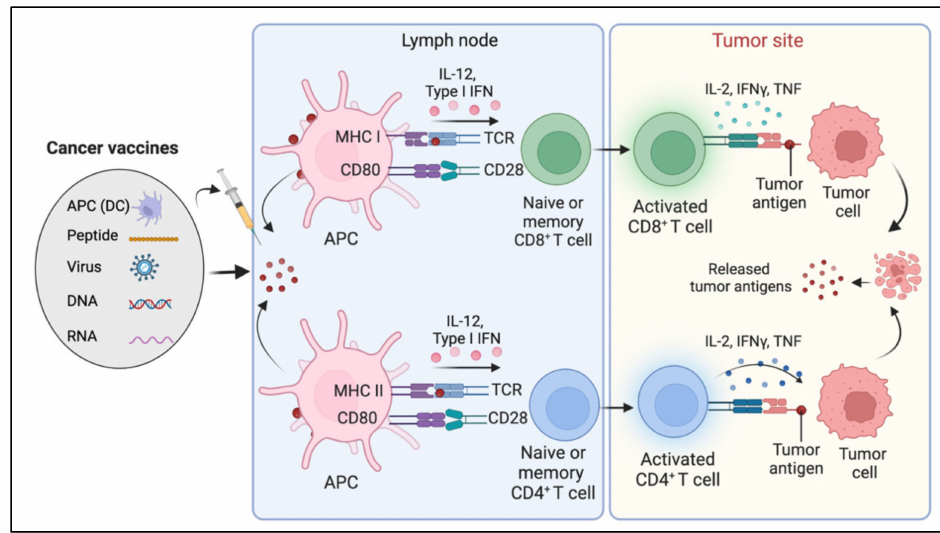
Figure 6. The schematic outline of the mode of action of cancer vaccines. After the administration of a cancer vaccine, APCs such as dendritic cells (DCs) update the antigens, process them, and present them on MHC-I and MHC-II molecules. Antigen-loaded DCs then transmits the signal to cytotoxic T cells through MHC-I and helper T cells through MHC-II, leading to their activation. Upon activation, antigen-specific CD4 + or CD8 + , T cells migrate to the tumor microenvironment and release cytokines that induce killing of tumor cells. Adapted from BioRender.com. (Abbreviations: TCR, T cell receptor; MHC-I and MHC-II, major histocompatibility complex I and II; CD, cluster of differentiation; APC, antigen-presenting cell; IFN, interferon; IL, interleukin; TNF, tumor necrosis